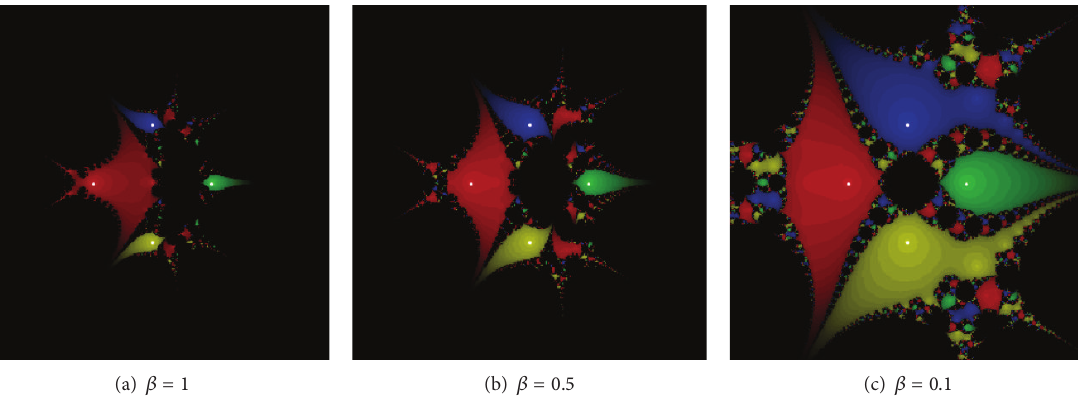
Figure 1: Scheme (3) for the test problem 1.